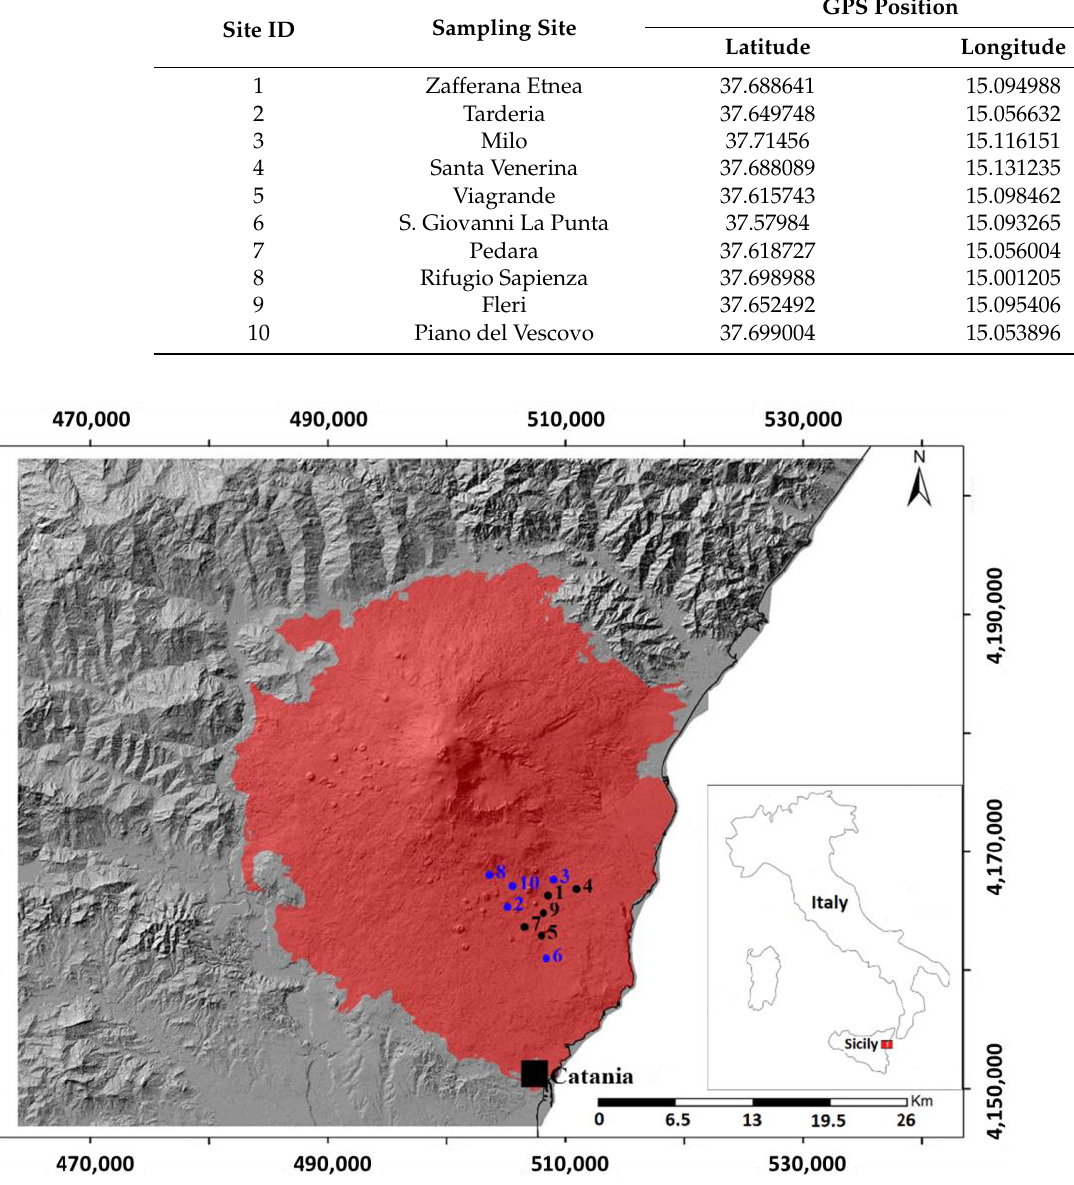
Figure 1. The map of the sampling area. The site IDs of freshly erupted air-fall pyroclastic products (black circle), and of heaps of pyroclastic wastes from previous volcanic activities (blue circle) are reported.